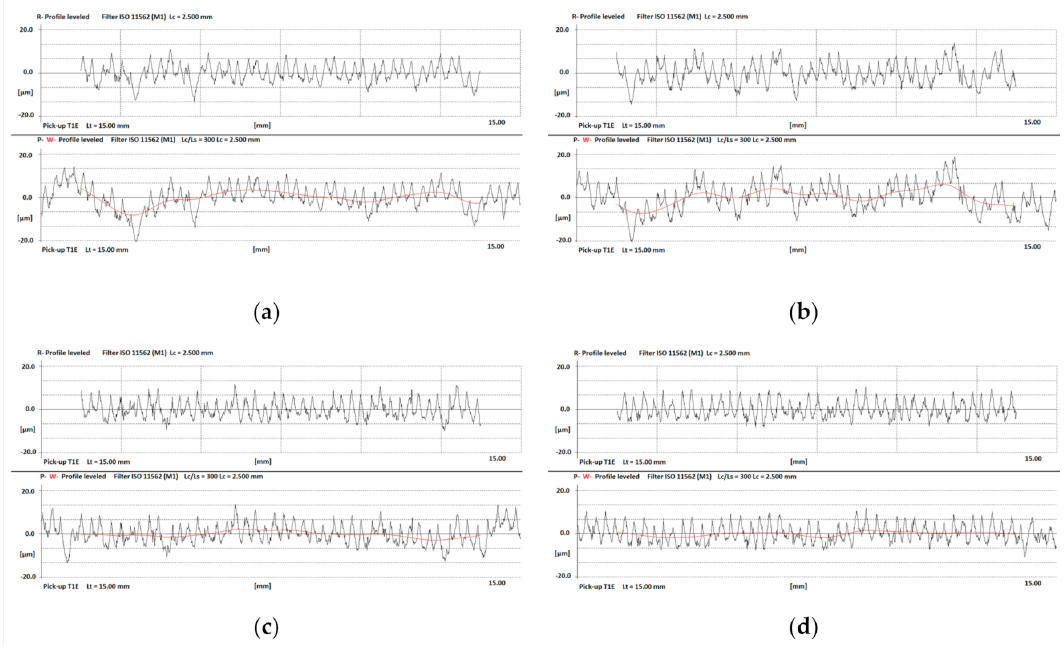
Figure 4. R, W, and P profiles of the third machined sample (L/D = 12; S355JR): ( a ) section 1, ( b ) section 2, ( c ) section 3, ( d ) section